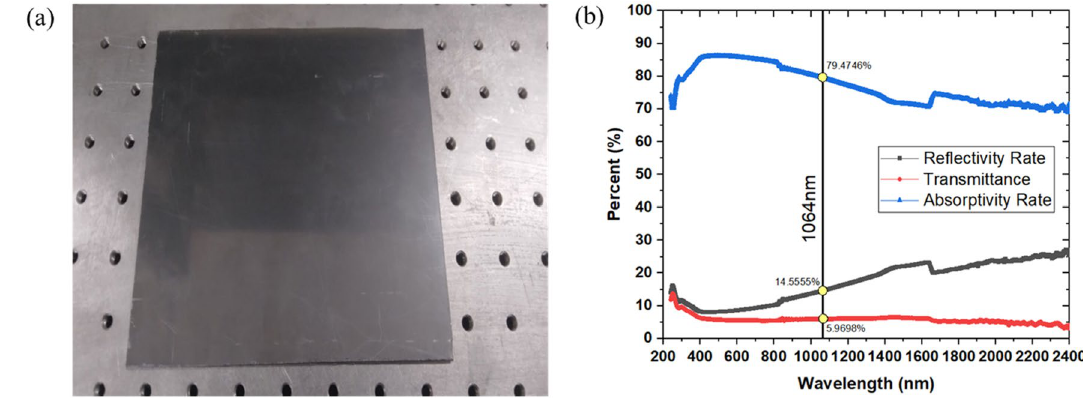
Figure 1. ( a ) A CNT composite plate ( b ) reflectivity, absorptivity and transmittance of the plate in ( a